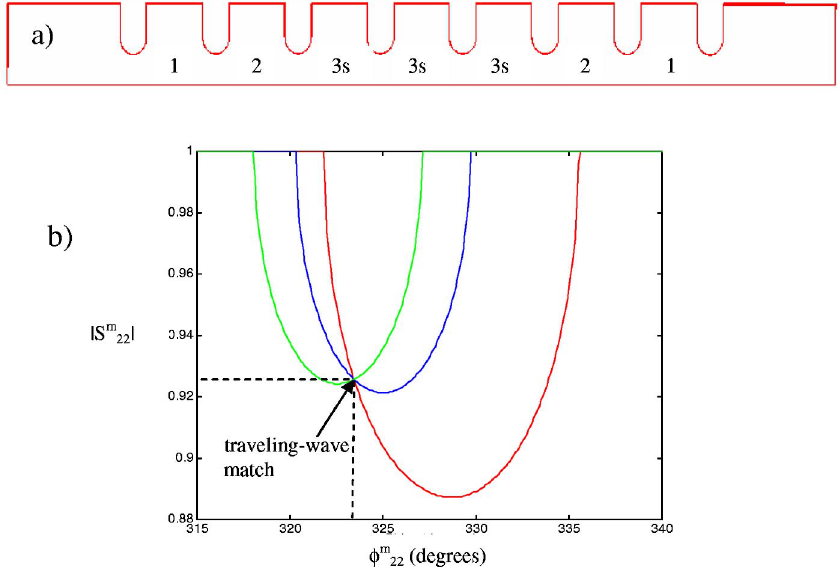
FIG. 7. (Color) (a) Profile of symmetric geometry modeled with field solver and (b) example of Eq. (1) solution for symmetric geometries composed of the initial structure cells and one (green), two (blue), and three (red) periodic central